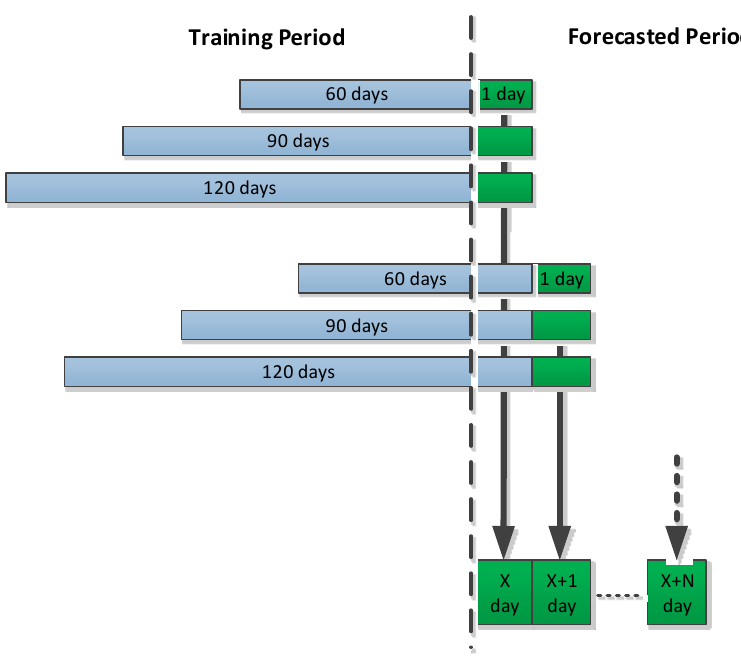
Figure 3. Next day mobile window forecast with different number of training days considered.